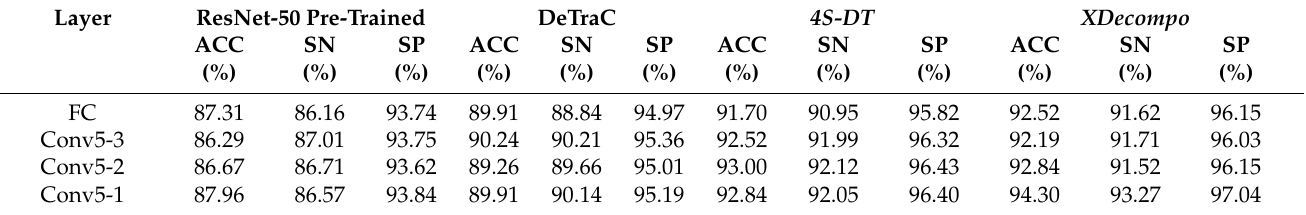
Table 8. Overall classification performance of each model on the testing set of the Brain tu- mour dataset.